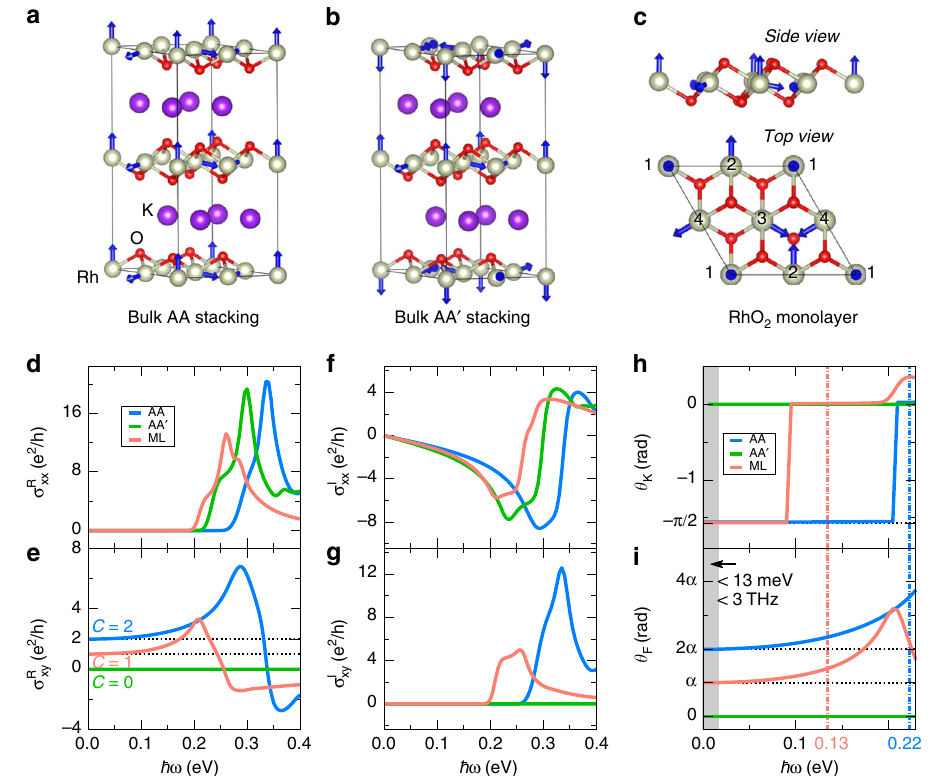
Fig. 4 Quantum topological magneto-optical effect in K 0.5 RhO 2 . a , b Bulk AA and AA ′ stackings of K 0.5 RhO 2 . c Side and top views of RhO 2 monolayer (ML). d – g The optical conductivities of K 0.5 RhO 2 and RhO 2 ML. The results of K 0.5 RhO 2 are scaled by the length of crystallographic z axis. For RhO 2 ML, the Fermi energy is moved upward to the topologically nontrivial band gap E (see Supplementary Fig. 5). h , i The Kerr and Faraday rotation angles of g K 0.5 RhO 2 and RhO 2 ML. The dash-dotted vertical lines indicate the E of the AA-stacked K 0.5 RhO 2 (0.22 eV) and RhO 2 ML (0.13 eV). The shaded area g marks the low-frequency limit (e.g., _ ω < 0 : 1 E ML ’ 13 meV), in which the quantum topological magneto-optical effects can be measured by THz g spectroscopy. Spin – orbit coupling is not included in d – i